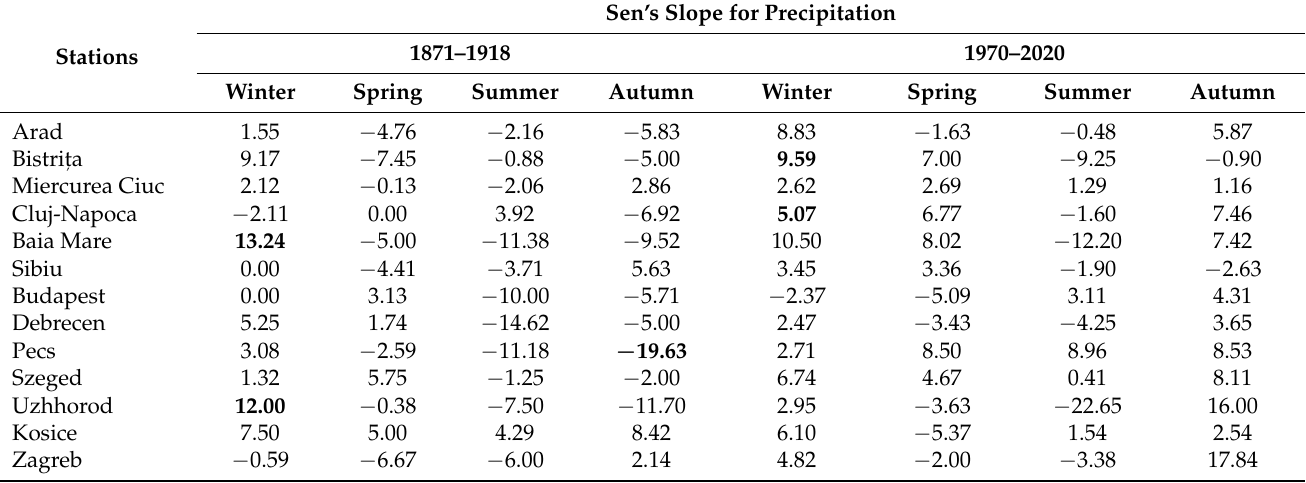
Table 6. Trend of precipitation (mm/decade) for historical (1871–1918) and current (1971–2020) periods in the Carpathian Region. +/ − signs indicate significant changes at the 0.05 significance